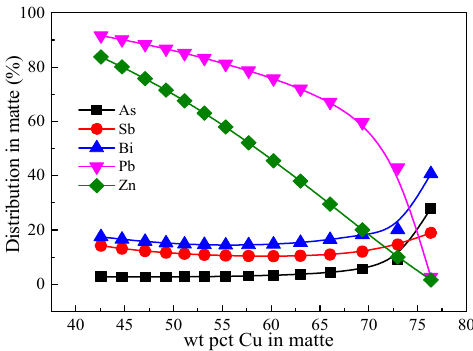
Figure 9. Minor elements distribution in slag calculated by SKSSIM.